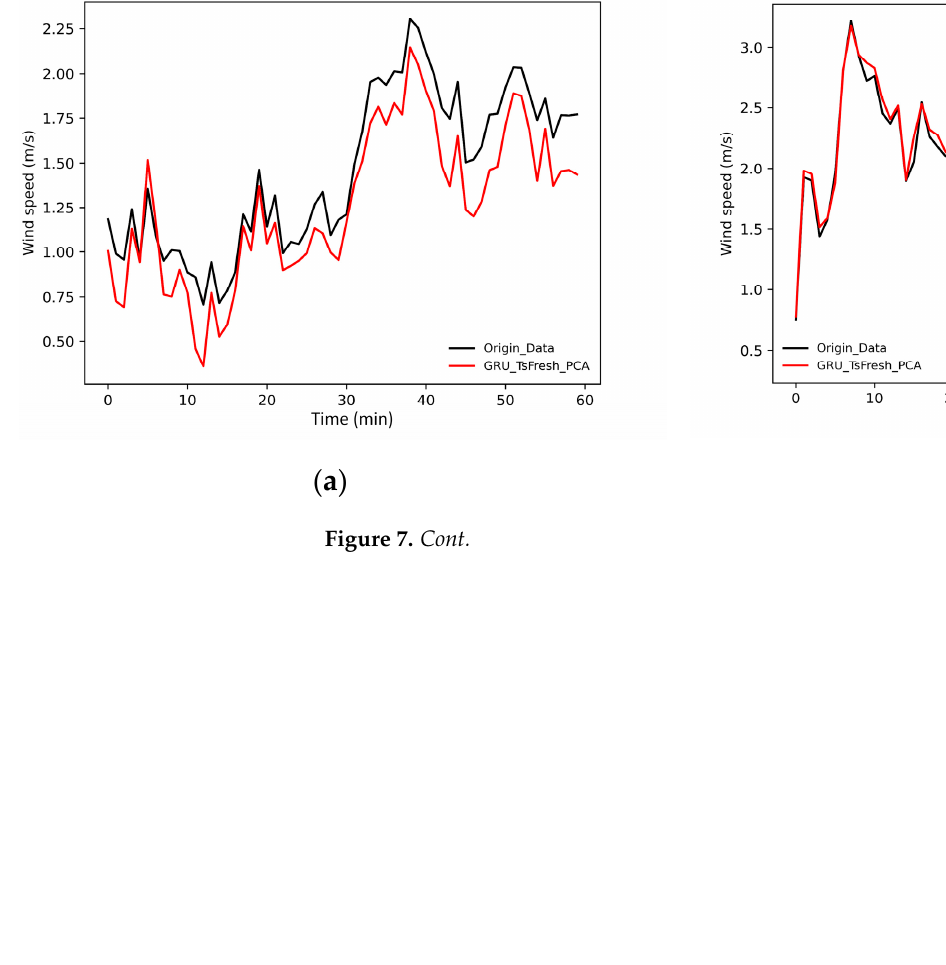
Figure 6. Correlation of features selected for the four datasets. ( a ) Feature correlation representation of spring dataset; ( b ) feature correlation representation of summer dataset; ( c ) feature correlation representation of autumn dataset; ( d ) feature correlation representation of winter dataset.